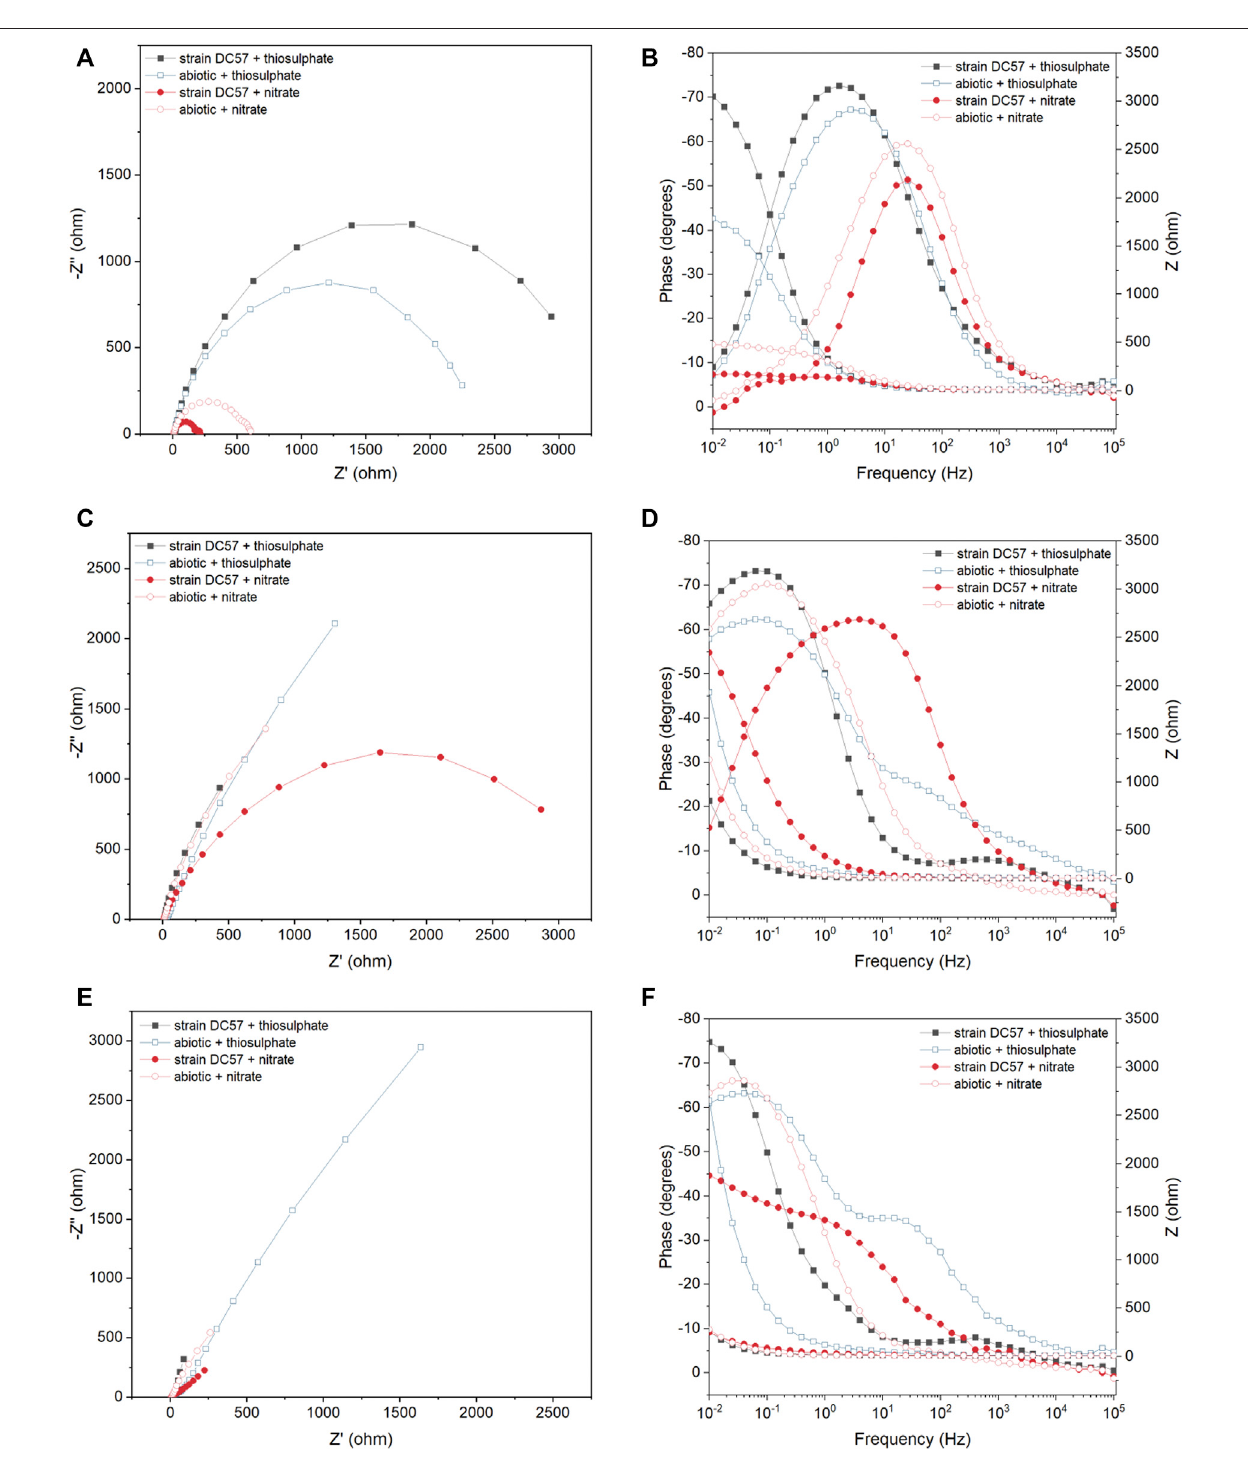
FIGURE 3 | EIS Nyquist plots (A,C,E) and Bode plots (B,D,F) of carbon steel after 1 (A,B), 8 (C,D) and 16 (E,F) days exposure to thiosulphate and nitrate reducing conditions.